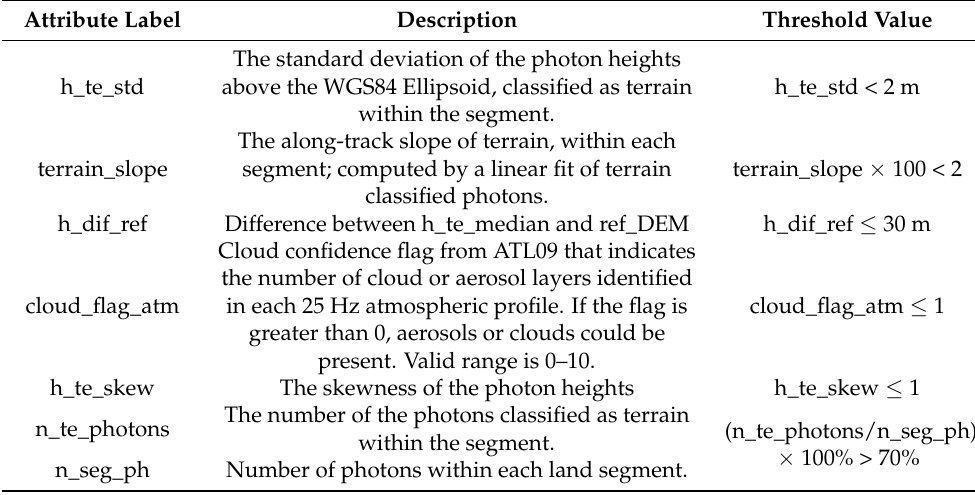
Table 1. Description of the evaluation